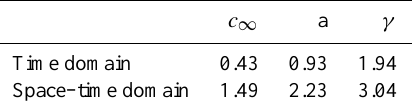
Table 4. Parameter values of the calibration relation in Eq. (1) of the STRAIN model for applications in the time and space–time do- mains, which are valid when expressing R in mmh − 1 .